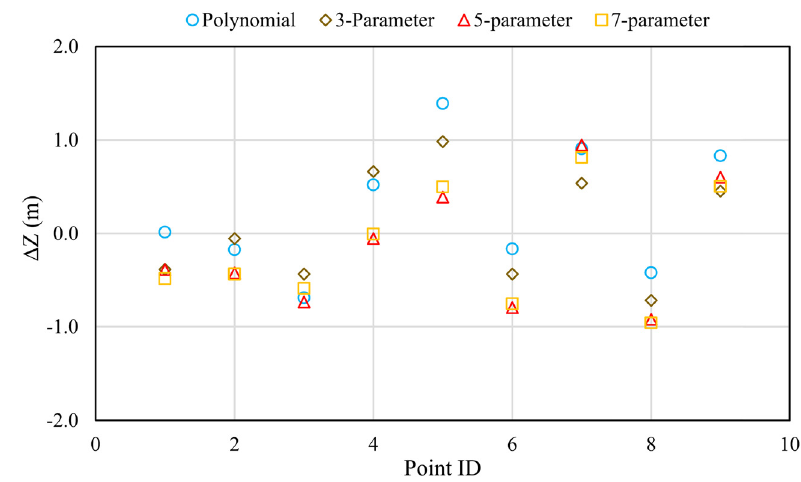
Figure 12: Z - coordinate di ff erences between measured and reproduced values at